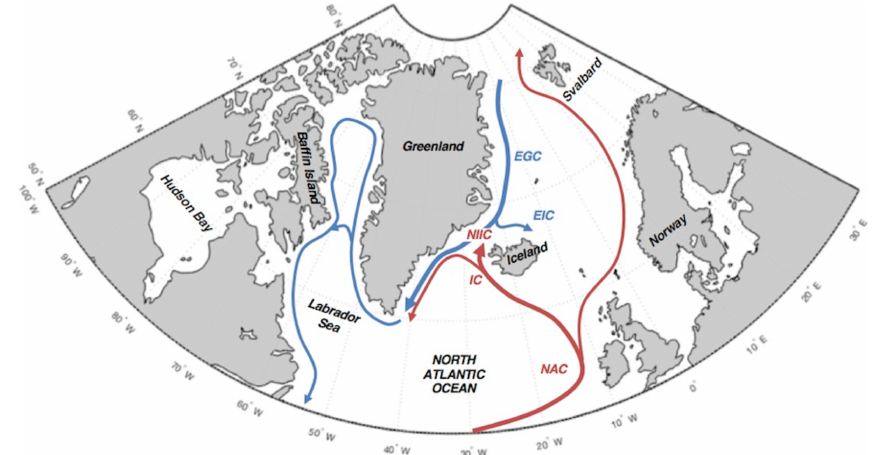
Figure 1. Location of Iceland in the northern North Atlantic relative to the major ocean surface currents. EGC: East Greenland Current; EIC: East Iceland Current; NIIC: North Icelandic Irminger Current; IC: Irminger Current; NAC: North Atlantic